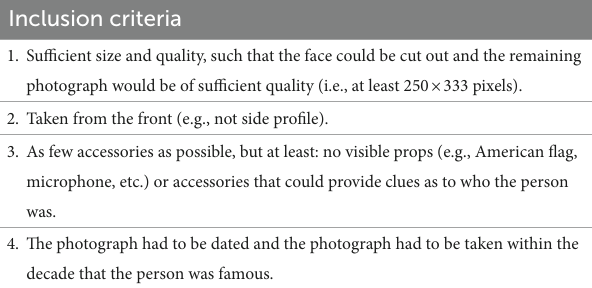
TABLE 3 Inclusion criteria for photographs of famous faces. Inclusion